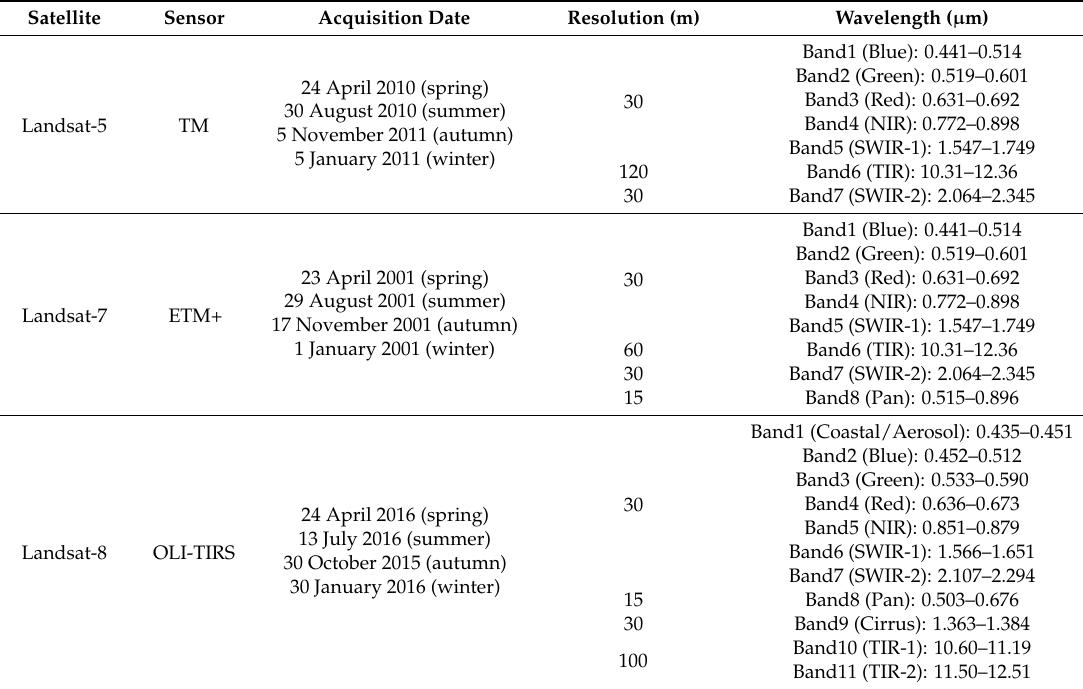
Table 1. Satellite images from the three Landsat sensors (TM, ETM+, OLI-TIRS) used in this study.